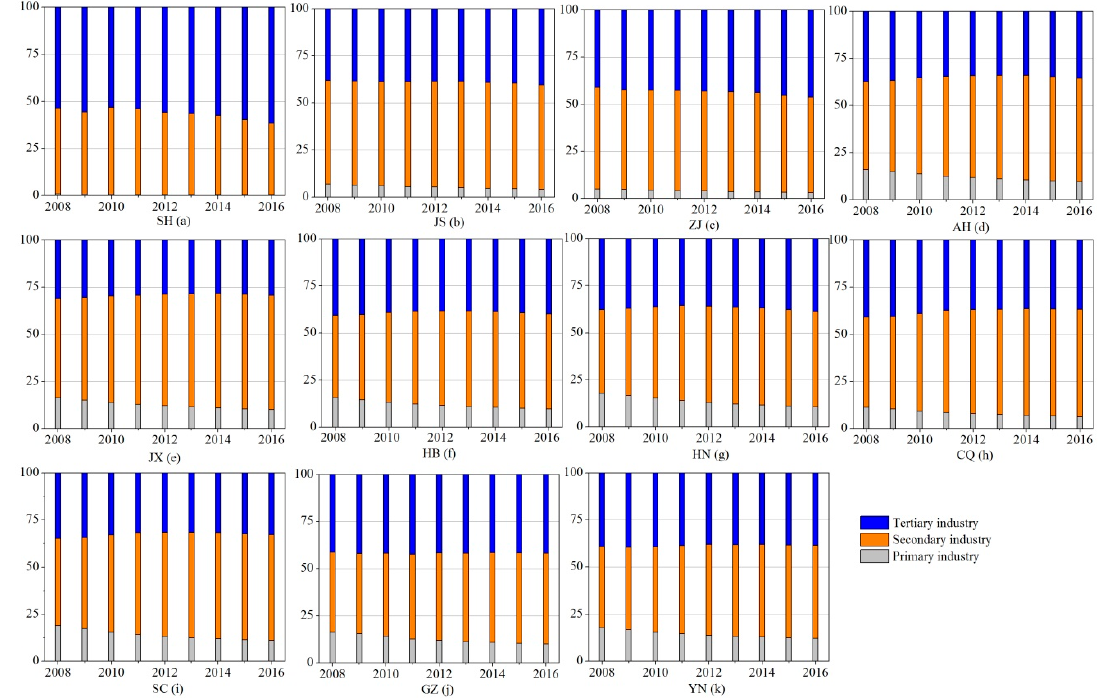
Figure A2. Industry structure in the YREZ during 2008–2016. ( a ) SH; ( b ) JS; ( c ) ZJ; ( d ) AH; ( e ) JX; ( f ) HB; ( g ) HN; ( h ) CQ; ( i ) SC; ( j ) GZ; ( k ) YN.